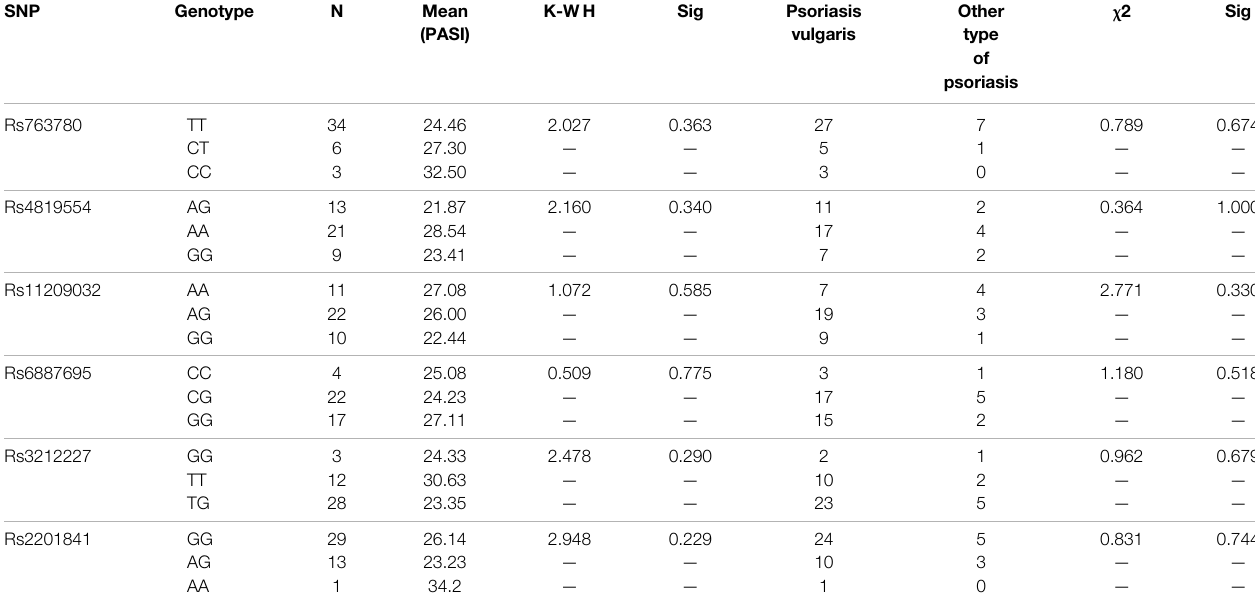
TABLE 3 | The relationship between each SNP and the in fl ammatory degree (PASI score)/different types of psoriasis. SNP